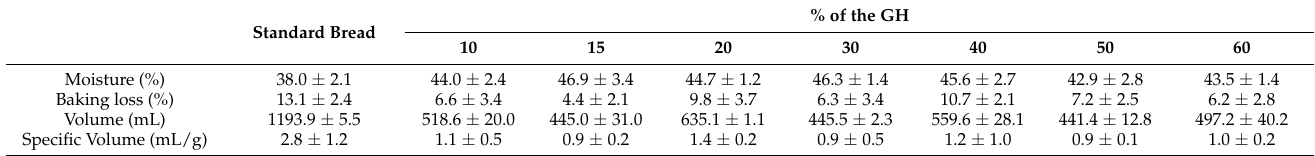
Figure 1. Standard and breads made with different amounts of GH is shown. The pictures of all the breads were taken with a standard black and white checkered box as a background image; the pictures of the bread were taken after resting the bread for a cooling period of 1 h. Table 1. The characteristics of standard bread versus GH